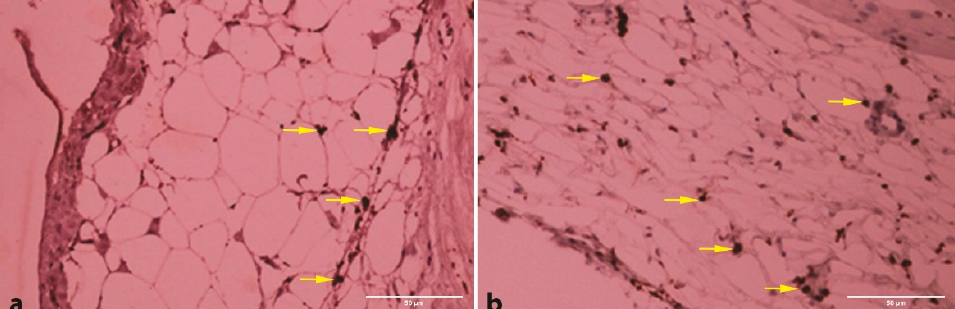
Figure 1. Immunohistochemical EAT analysis of the macrophages (CD68 200×) in CAD patients without CHF ( a ) and CAD patients with CHF ( b ).